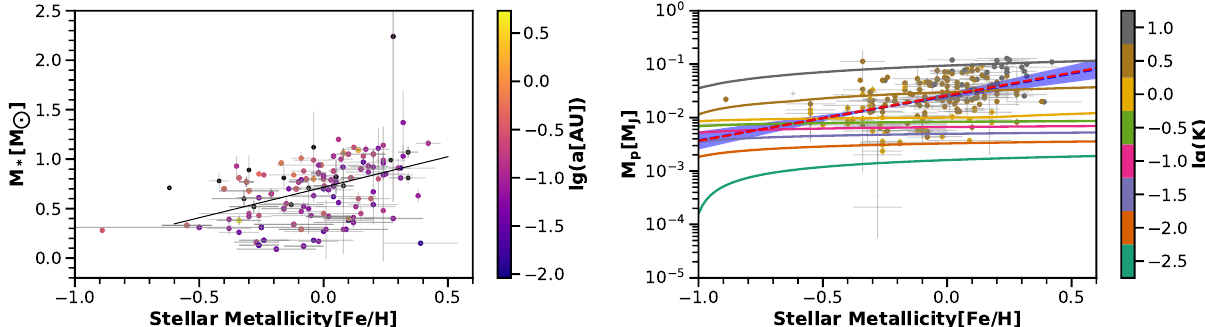
Figure 3. Left panel: stellar mass versus stellar metallicity for low-mass exoplanets. Unit of stellar mass is solar-mass. Unit of stellar metallicity is [Fe/H]. Right panel: planet mass versus stellar metallicity. The contour lines mark constant radial velocity amplitudes, which are computed based on the linear relationship of stellar mass and metallicity and the assumption of e = 0 and a = 0.1 AU, while the color of the dots indicate the RV (radial velocity) magnitudes of each planet, which is calculated by the properties (stellar mass, planetary mass, semi-major axis) obtained from the NASA Exoplanet Archive website. The dashed blue line is our regression results with the 95% confidence interval shown by the shadow